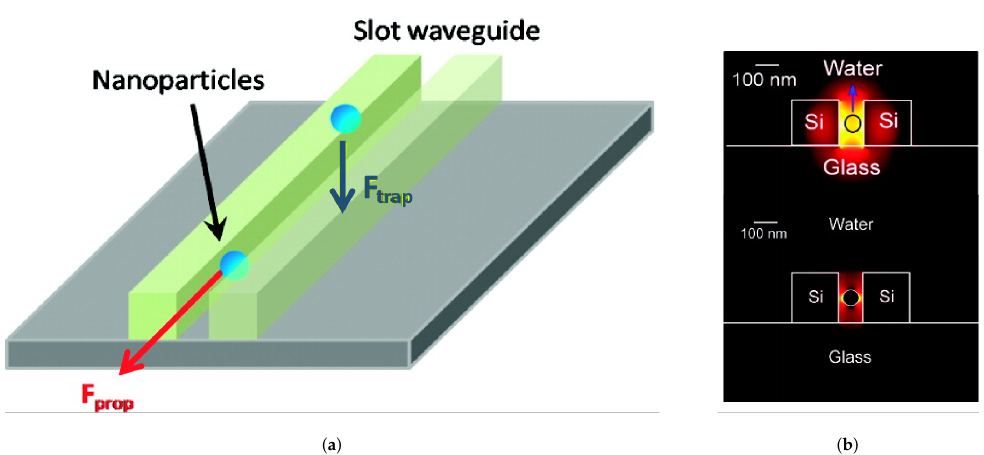
Figure 10. ( a ) Schematic illustrating the transport in a slot waveguide and ( b ) the mode profile for a SOI slot waveguide. Reprinted with permission from [77]. Copyright © 2009 American Chemical